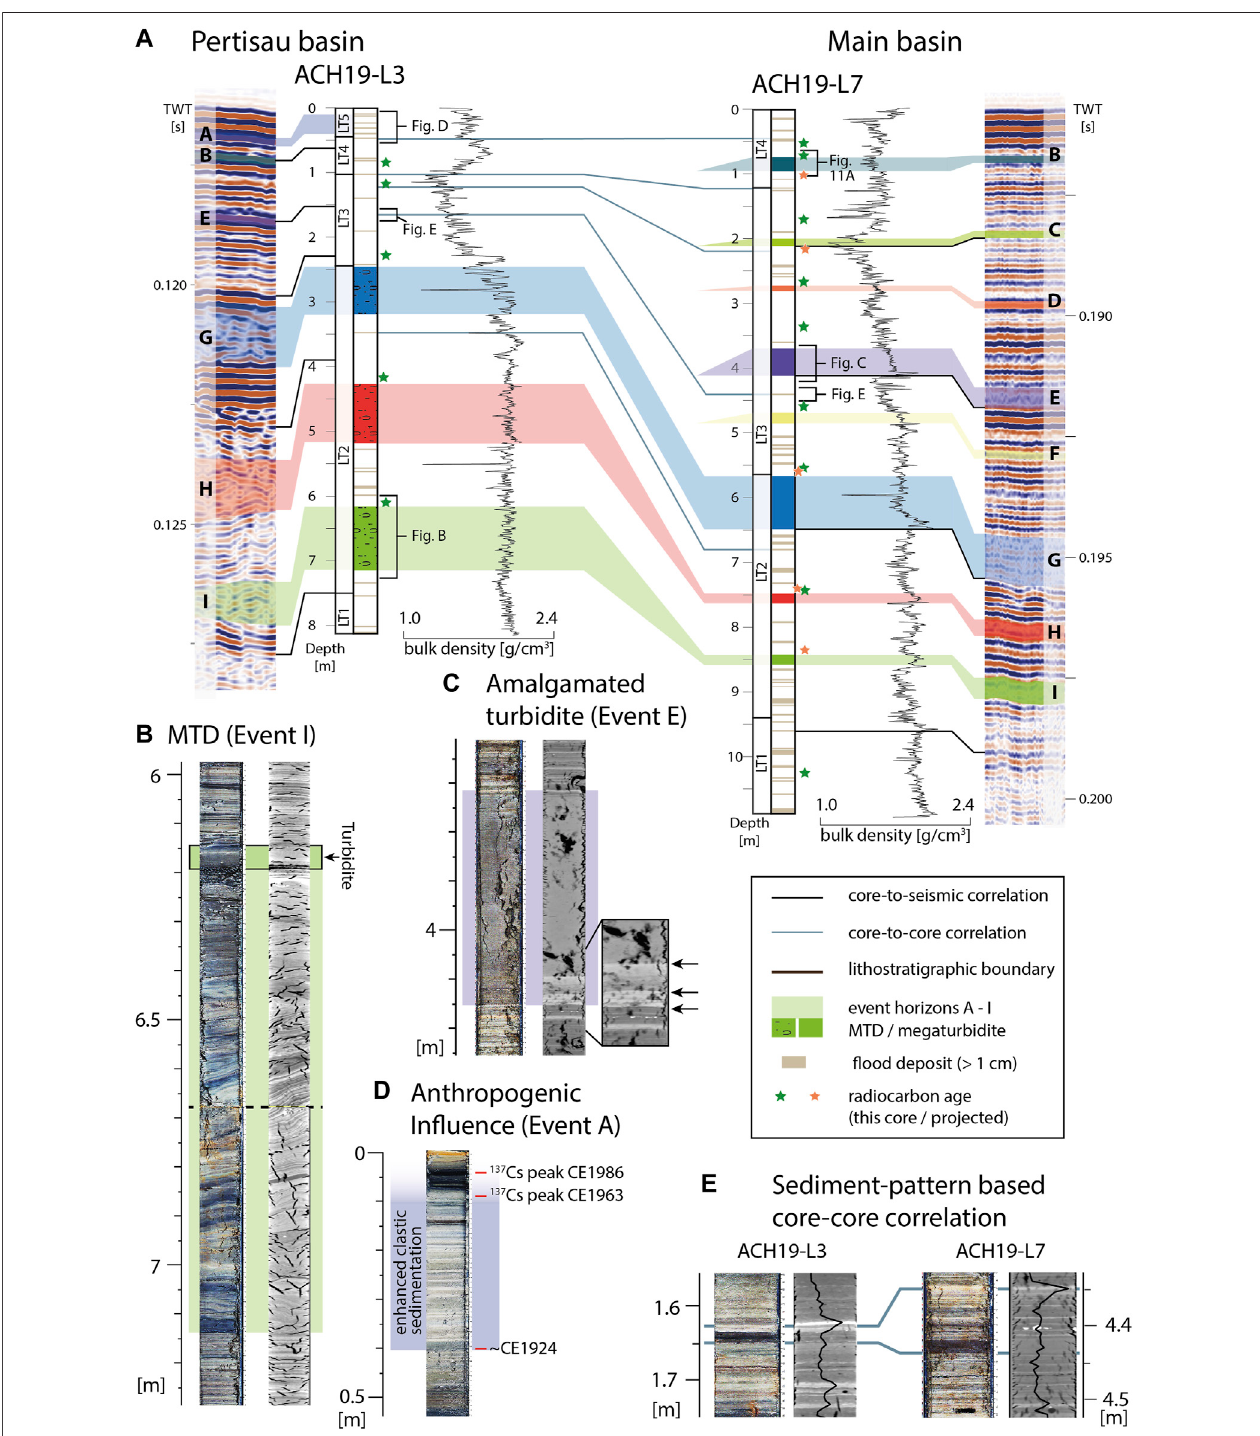
FIGURE 9 | Core data from the Pertisau basin (core ACH19-L3) and the Main basin (core ACH19-L7). (A) Correlation of seismic-stratigraphic event horizons A-I within the two basins is based on this core-to-core correlation using distinct marker horizons (blue lines), event deposits (MTDs and megaturbidites), density data within thedifferentlithostratigraphictypes(LT1 – 5)andveri fi edby 14 Cdatesinthecores.CoreimagesandCTdataareshownin SupplementaryFigureS1 .Coreimagesand CT data of the different lithotypes and event deposits are displayed in Supplementary Figures S2, S3 , respectively. Note that only events G, H and I are recognizableinbothcores. (B) CoreimageandCTscanofaMTDshowingfoldedanddistortedstrata,shearzonesandaturbiditeontop. (C) CoreimageandCTscanof an amalgamated turbidite consisting of ∼ 3 individual sedimentary pulses (black arrows; event E). Each of these pulses has an internally homogeneous character. This